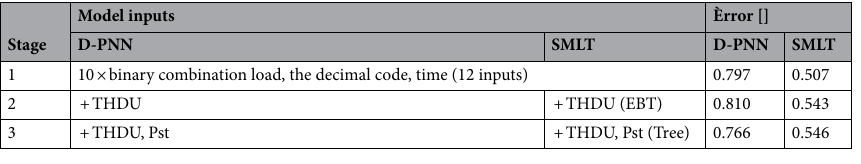
Table 5. Pst 3-step